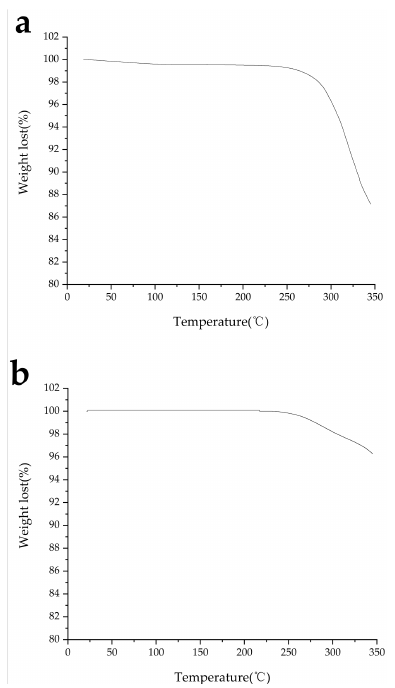
Figure A1. The TGA thermograms of ( a ) ERL MPs and ( b ) ERL